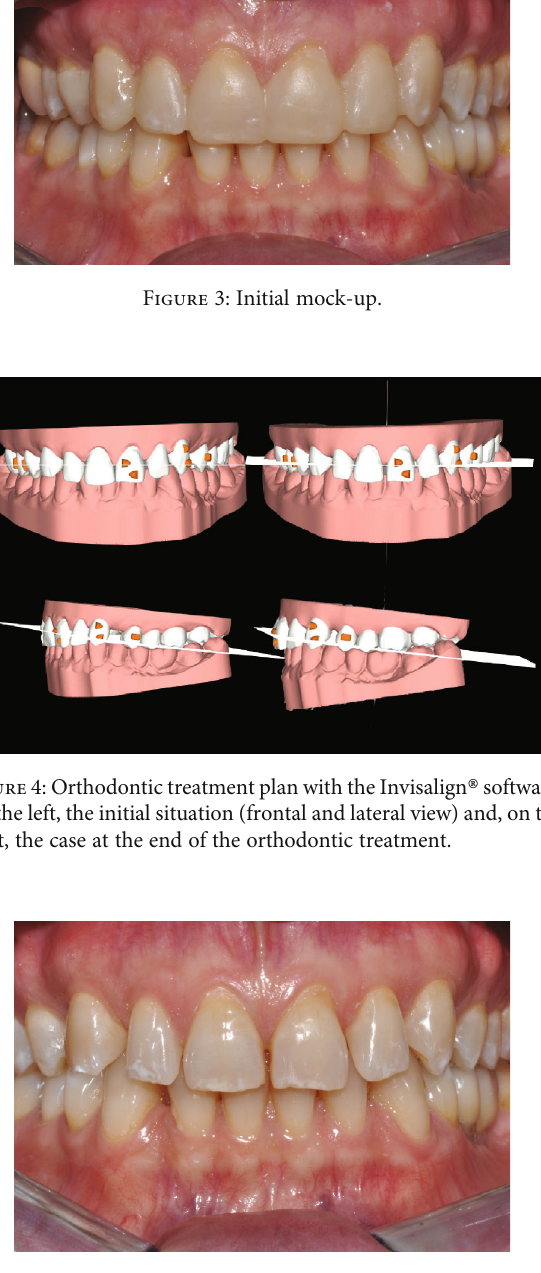
Figure 5: Completion of orthodontic treatment.